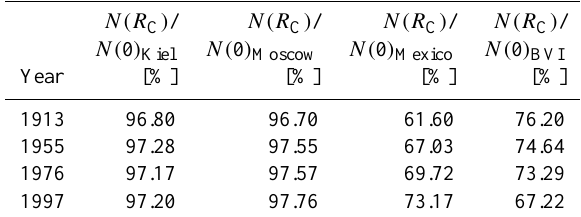
Fig. 7. NM latitude scan by Villoresi et al. (1997) (red circles, with a Gaussian fit plotted as black line) and the corresponding counting rate variations N(R C ) normalized to the counting rates at polar regions N( 0 ) at Mexico City, the BVIs, Moscow and Kiel. The color coding of the lines stand for the same years as in Fig. 6. Table 1. Location-dependent computed cutoff rigidity values for Table 2. Read-out counting rates during the solar minimum condi- times with an annual mean solar modulation value of φ = 410 MV tions of 1913, 1955, 1976 and (1913, 1955, 1976 and 1997; see Usoskin et al., 2011).